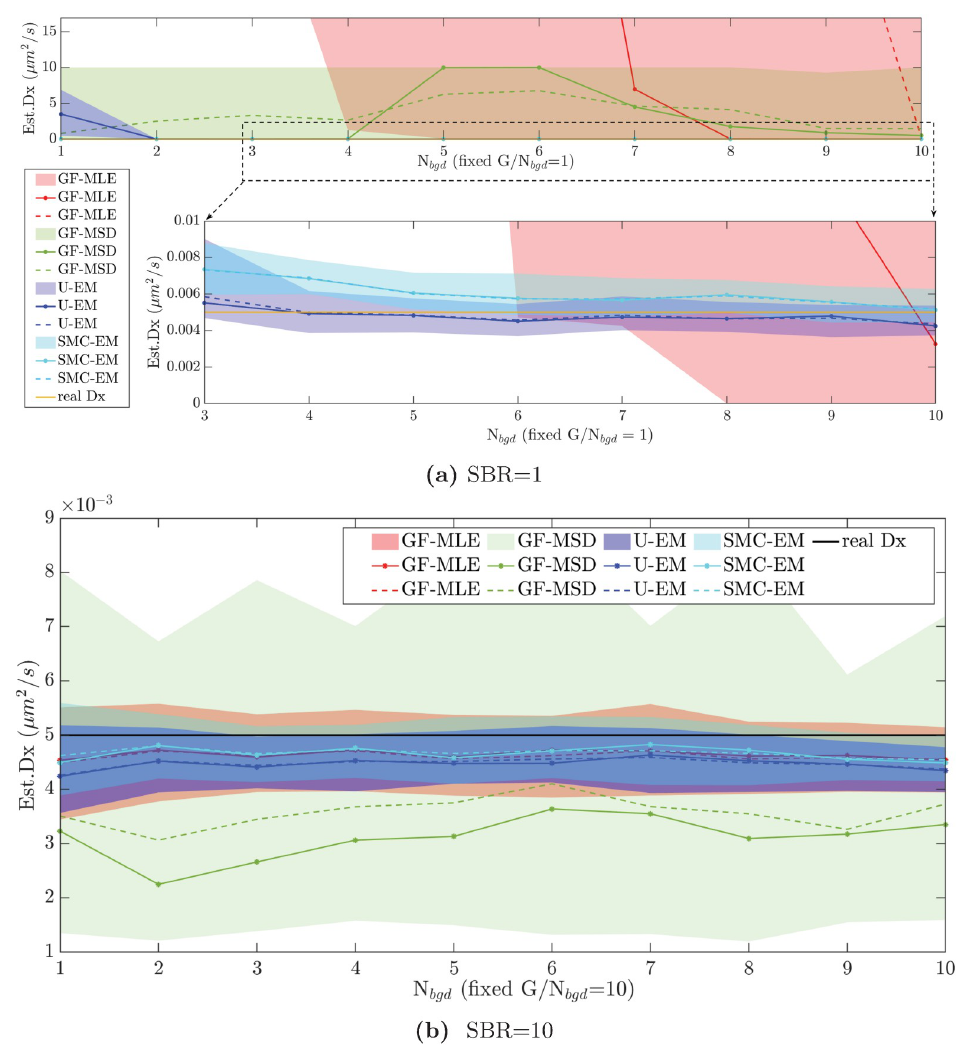
Fig 8. Diffusion coefficient estimation performance over 100 simulation runs at different signal and background levels. With fixed (a) SBR = 1 and (b) SBR = 10. Shown are the middle two quantiles (colored, shaded area), median (solid line), and mean (dashed line) using GF-MLE (red), GF-MSD(green), U-EM (purple), and SMC-EM 500 (cyan). The true value was D x = 0.005 μ m 2